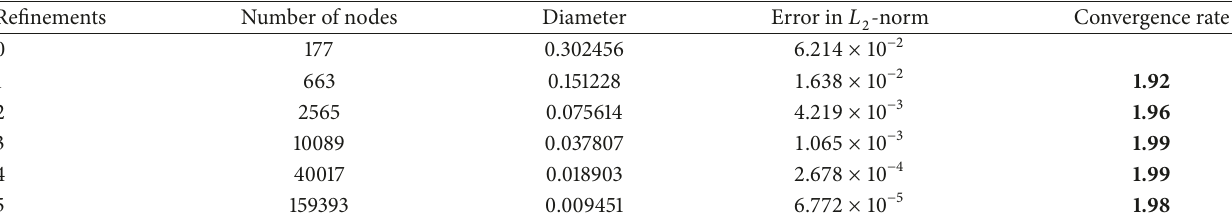
Table 4: Order of convergence in 𝐿 2 -norm for mixed Neumann-Dirichlet